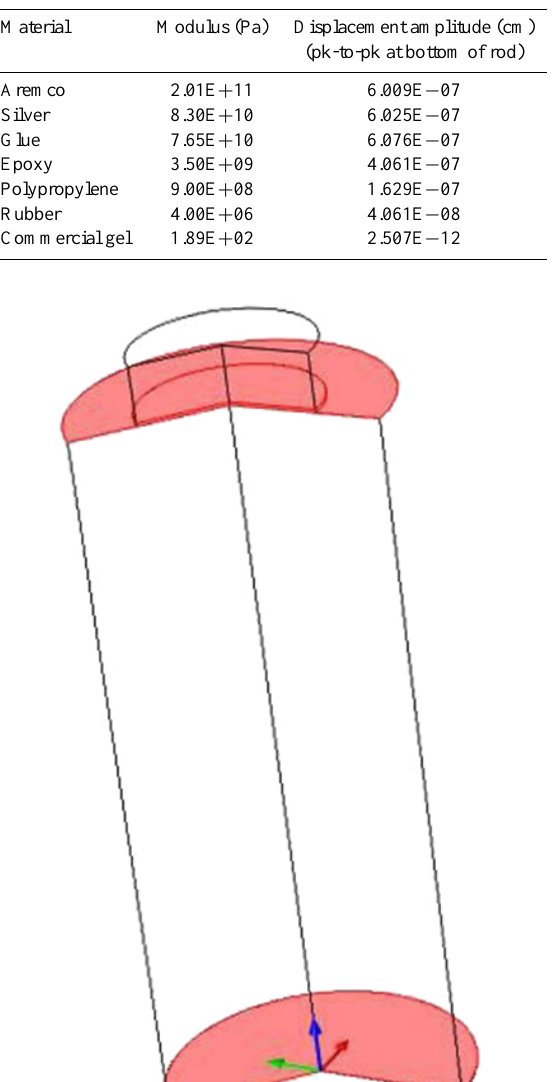
Table 4. Materials used and corresponding Young’s modulus values and the resulting peak-to-peak displacement of the wave at the end of the Invar 42 rod from the COMSOL model.